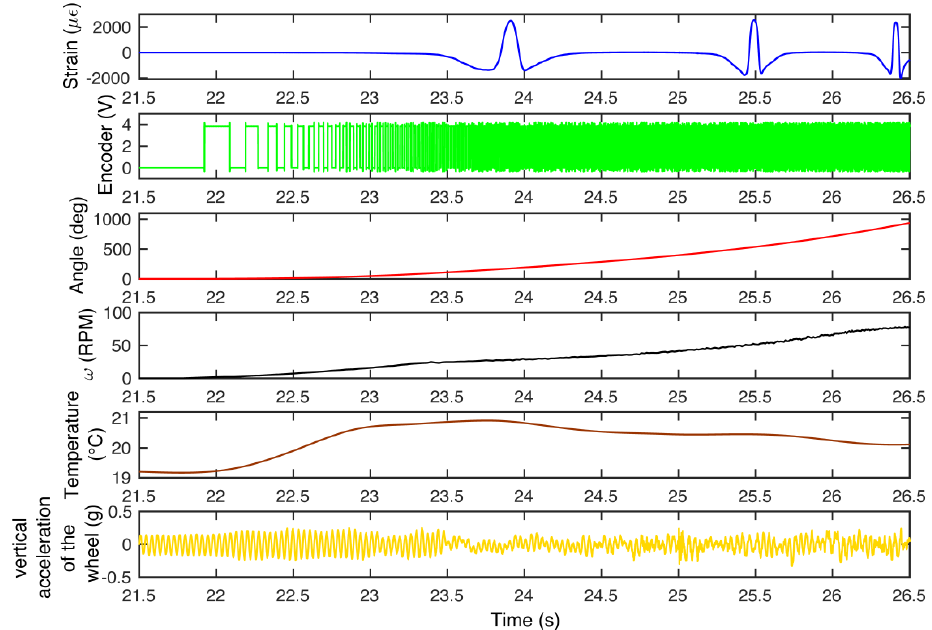
Figure 23. Multi-sensor data logs: Strain, Encoder output voltage, Angle, Rotational speed, Temperature, and Wheel hub vertical acceleration, respectively.